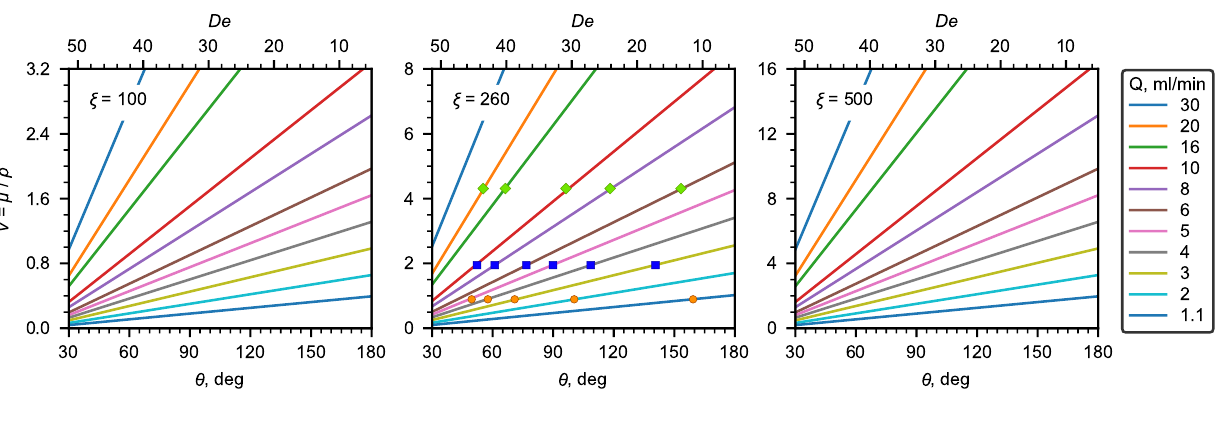
Figure 7. Nomograms of kinematic viscosity at different ξ